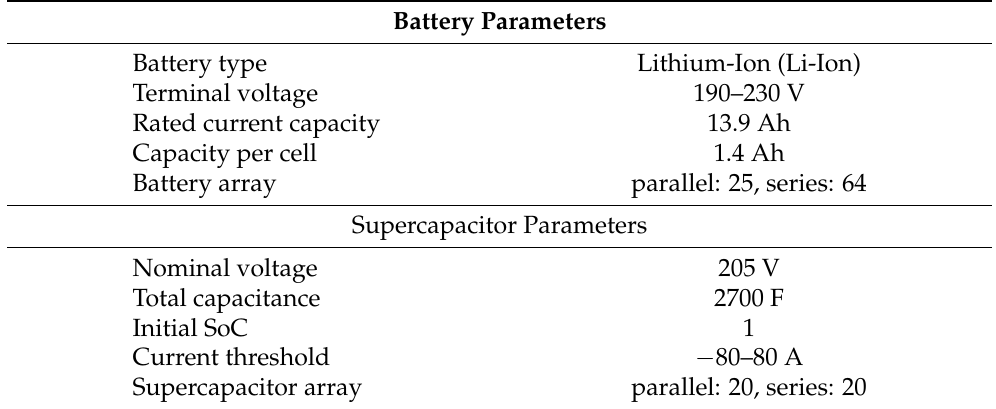
Table 2. Battery and supercapacitor parameters.